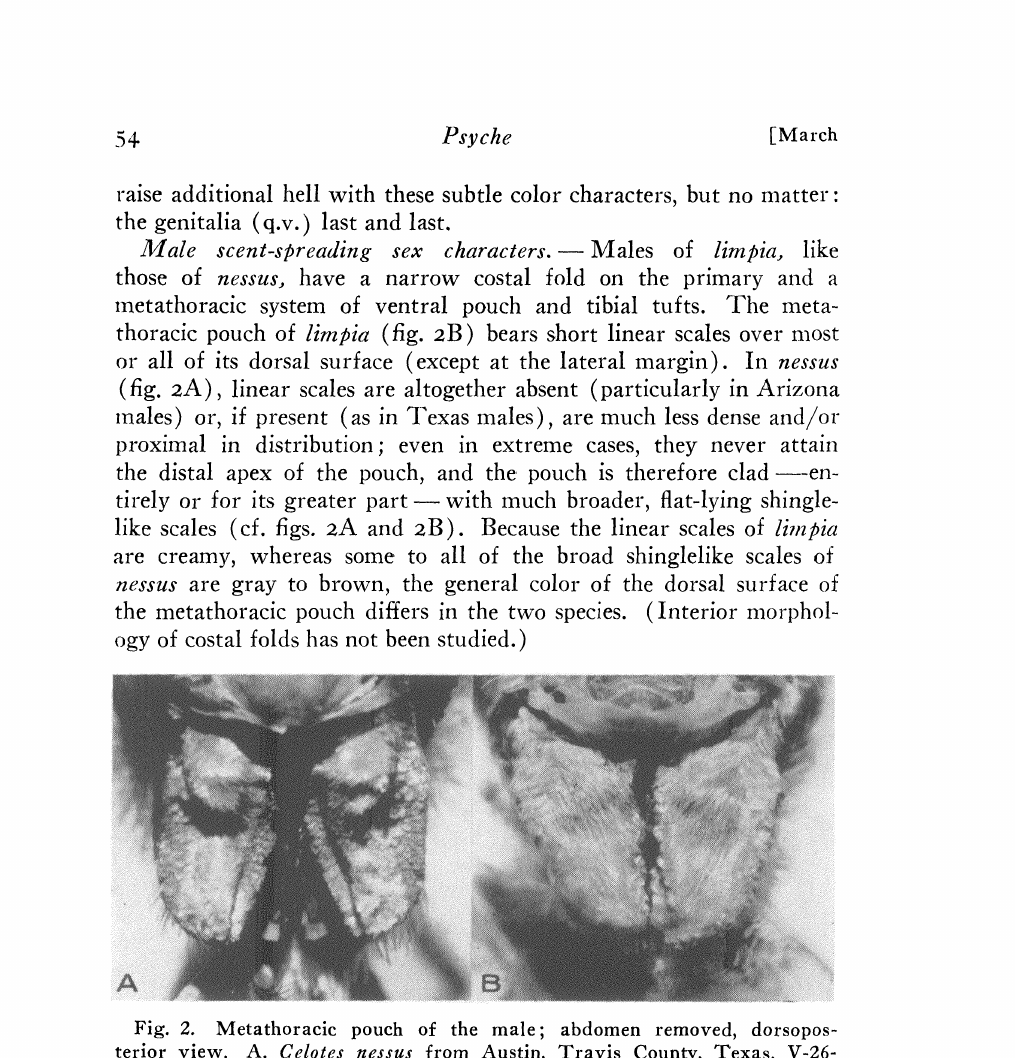
Fig. 2. Metathoracic pouch of the male; abdomen removed, dorsopos- terior view. A. Celotes nessus from Austin, Travis County, Texas, V-26- 1966 (J. M. Burns). B. Celotes limpia, a paratype reared out IX-10-1966 from a larva collected on ztbutilon malacum, 15 mi. SE Redford, 2500 ft., Presidio County, Texas, VIII-18-1966 (R. O.